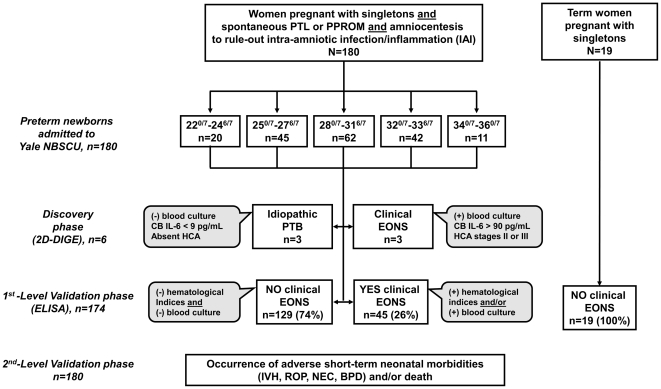
Flowchart representation of the stepwise study design and of the subject groups analyzed in each phase.Abbreviations: PTL, preterm labor; PTB, preterm birth; PPROM, preterm premature rupture of membranes; NBSCU, New Born Special Care Unit; CB, cord blood; EONS, early-onset neonatal sepsis; HCA, histological chorioamnionitis; IVH, intraventricular hemorrhage; ROP, retinopathy of prematurity; NEC, necrotizing enterocolitis, BPD, bronchopulmonary dysplasia; 2D-DIGE, two-dimensional differential-gel-electrophoresis.